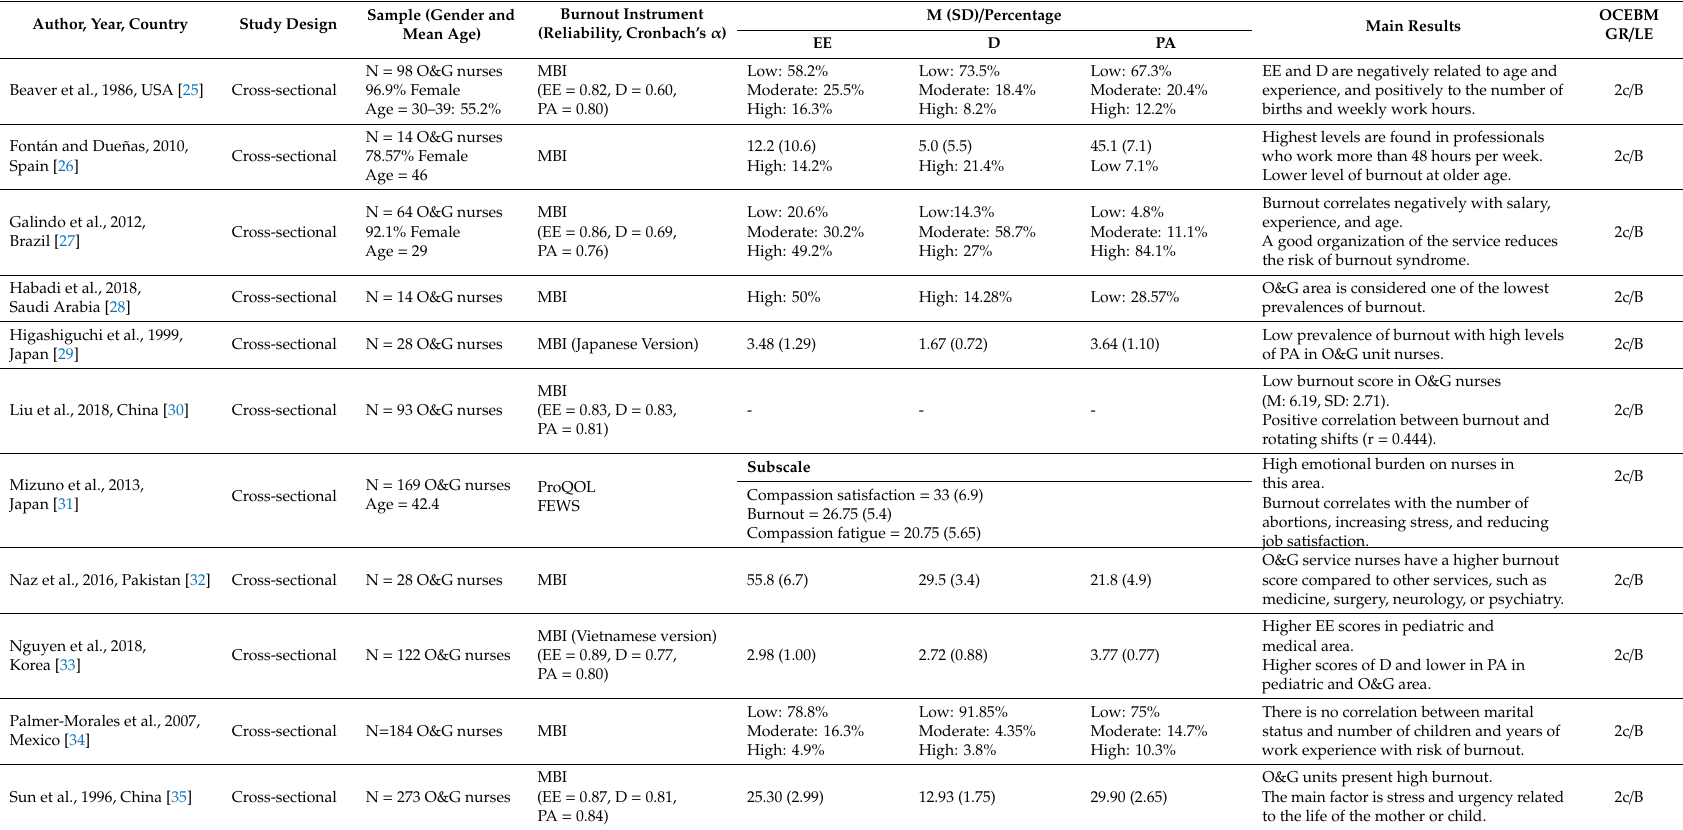
Table 1. Characteristics of the studies